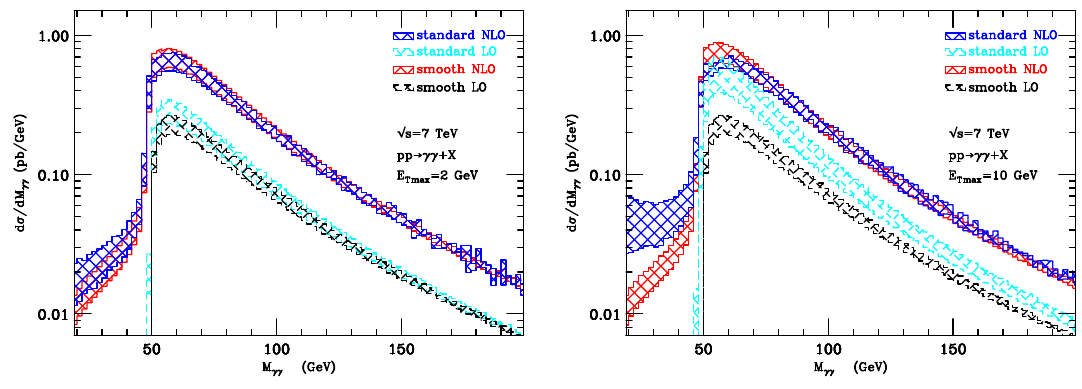
Figure 3 . The M γγ differential cross section for E T max = 2 GeV (left panel) and E T max = 10 GeV (right panel) and with the same photon kinematical cuts as in figure 2. The scale variation bands of the LO and NLO results for smooth and standard isolation are as follows: LO smooth isolation (black dashed), LO standard isolation (light-blue dashed), NLO smooth isolation (red solid) and NLO standard isolation (blue